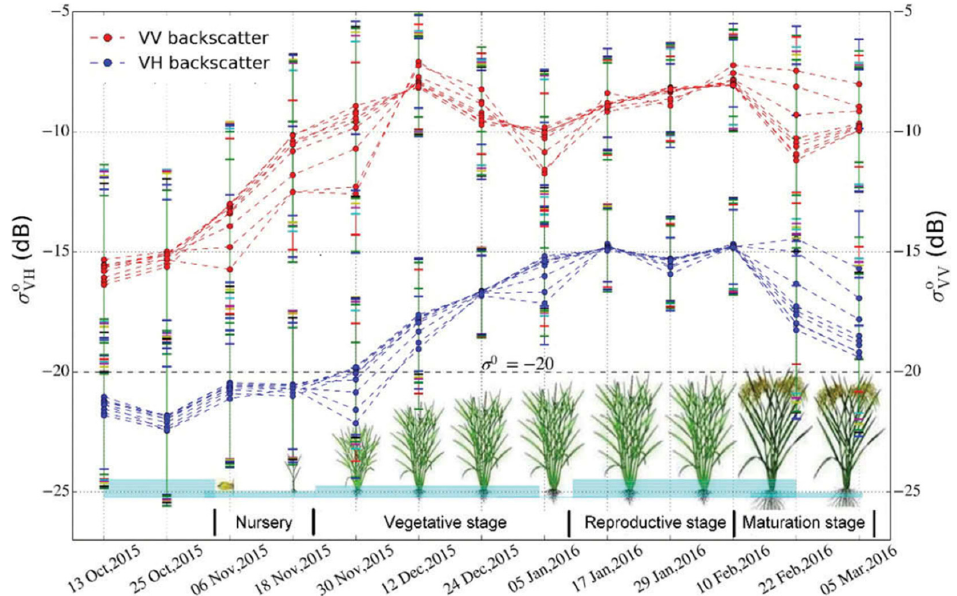
Figure 4. Temporal VH and VV backscatter intensities on rice growth development, including pre- paring planting bed, nursery, vegetative stage, reproductive stage, and maturation stage, adopted from Nguyen et al. [91]. from Nguyen et al.